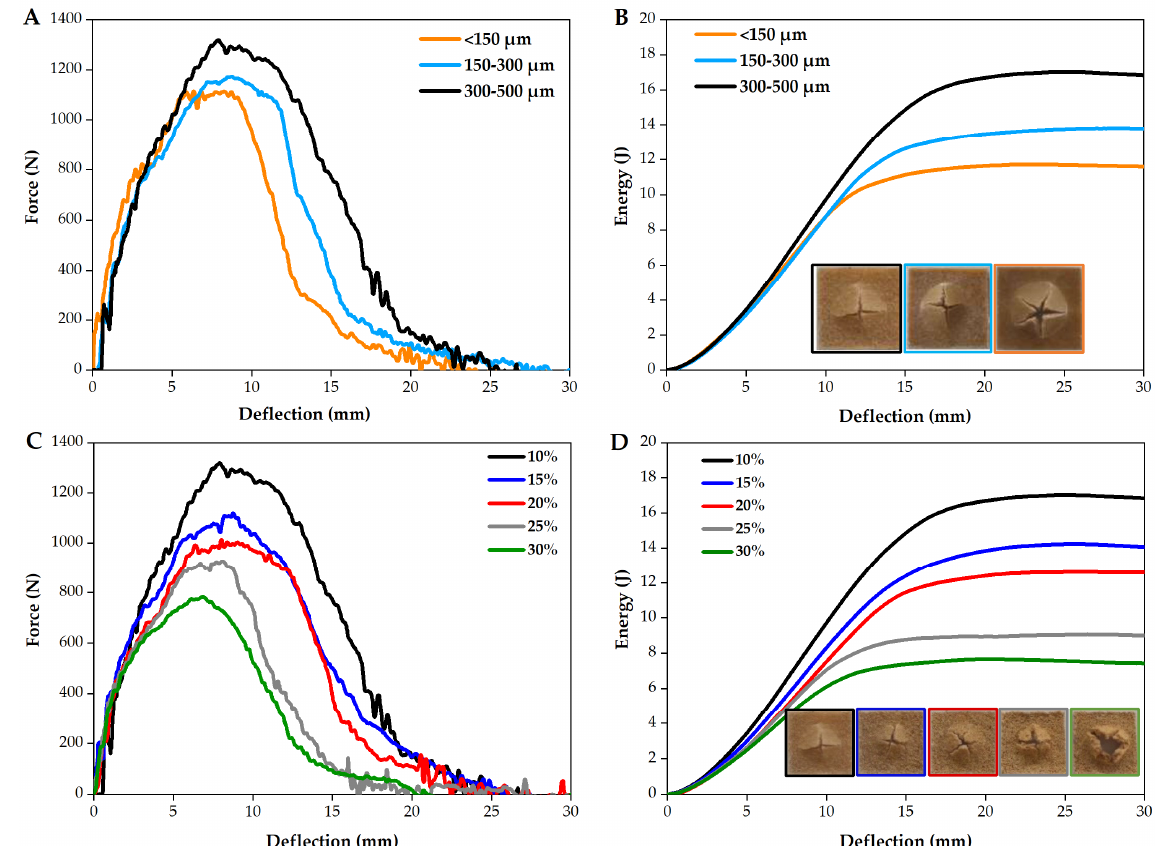
Figure 12. Force-deflection curve and energy-deflection curve of PE/wood as a function of wood granulometry ( A , B ) for parts with 10% wood and ( C , D ) wood content for parts processed with 300–500 µm wood.